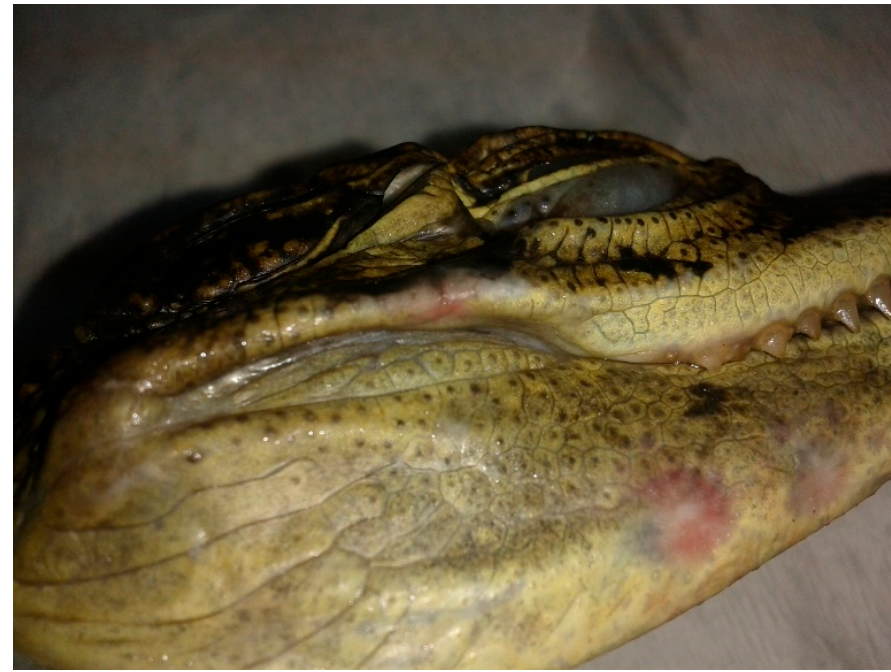
Figure 1. Round pale lesions on the skin of the mandible of the brown caiman.